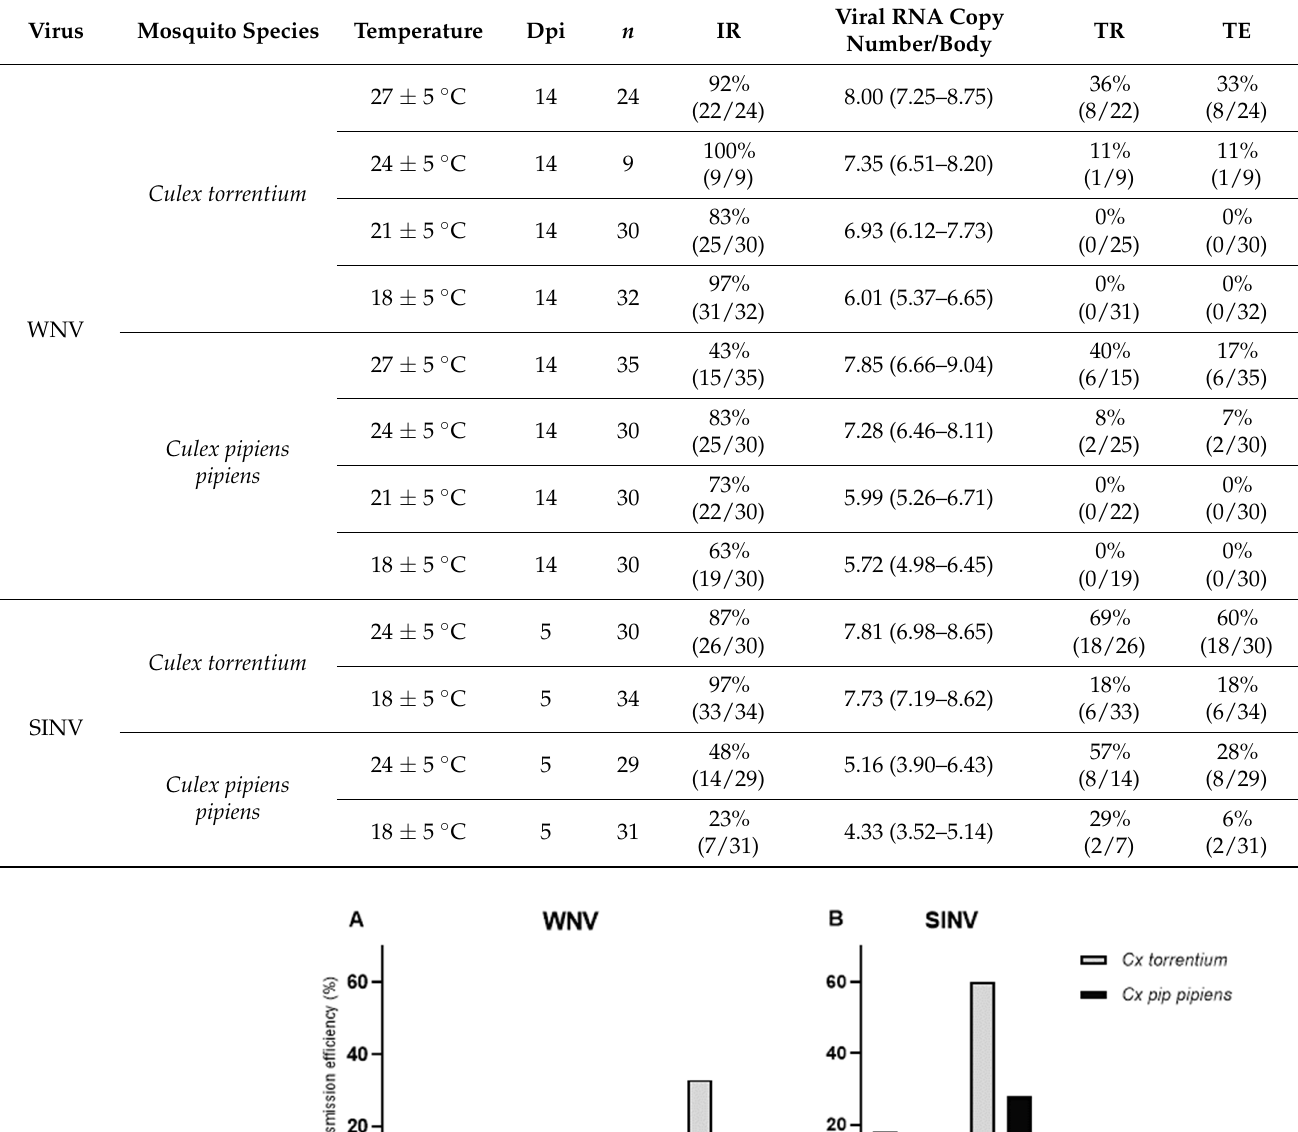
Table 1. Infection rates (IR), viral RNA copy number/body (Mean (95% confidence interval) log10 RNA copies/specimen), transmission rates (TR) and transmission efficiency (TE) of Culex torrentium and Culex pipiens biotype pipiens at 70% humidity and different temperatures for arbovirus infection with Sindbis virus (SINV, 5 days post-infection (dpi) or West Nile virus (WNV, 14 dpi) at an MOI of 10E7 PFU/mL). n = number of investigated specimens.